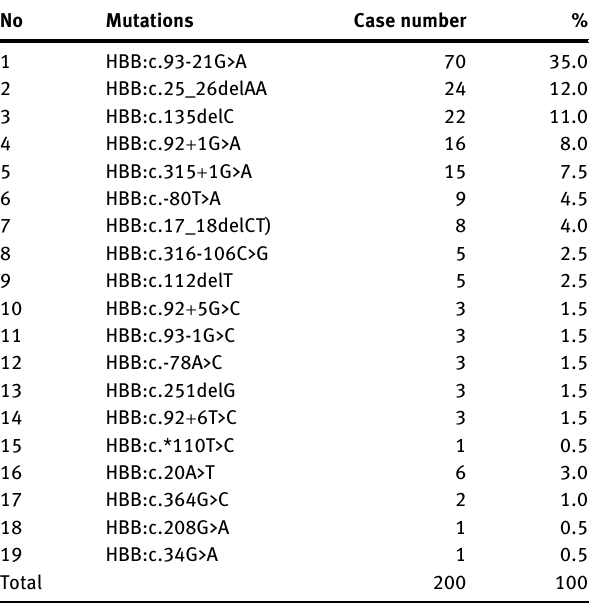
Table  : Distribution of the β -globin gene mutations in the region. No Mutations Case number